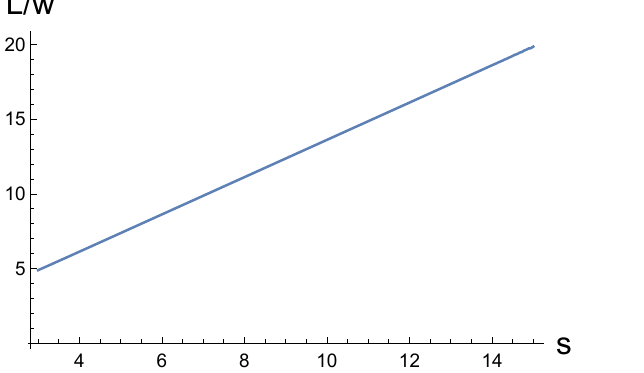
Figure 2 . The plots of kK ( k ) (solid line) and ln(4 /